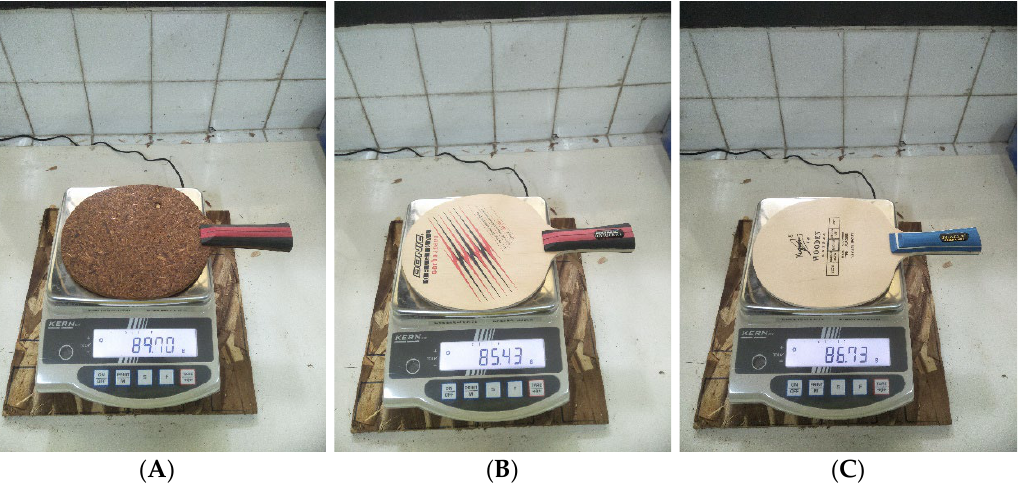
Figure 1. TTBSB-particleboard prepared at 200 °C for 20 min, TTBSB-Particleboard ( A ), Donic blade ( B ), and Yuguan blade ( C ).